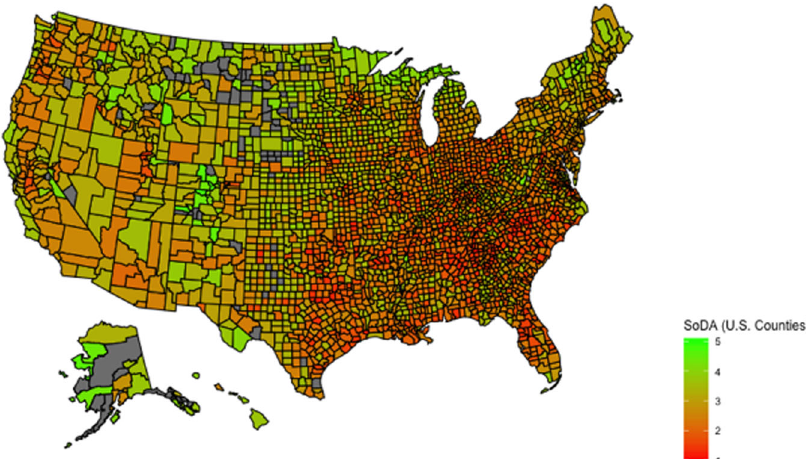
Fig. 1 Social Distancing Adherence (SoDA) heat map by United States county. Authors ’ analysis of data from the Unacast Social Distancing Dataset between from March 16, 2020 ( fi rst day of the national stray at home order) to April 24, 2020 ( fi rst day a state relaxed the social distancing guidelines). States that are grey did not have suf fi cient amount of cellphone data to be